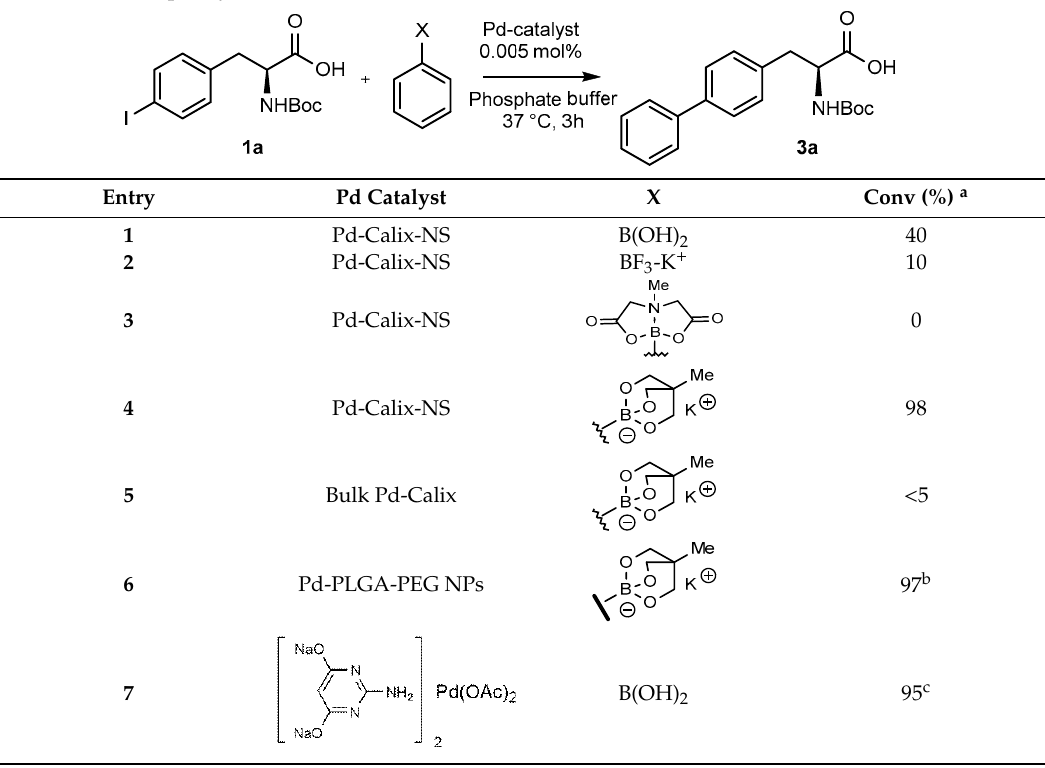
Table 2. Influence of the organoboron derivative on the cross-coupling reaction of N -Boc-4-iodo- l